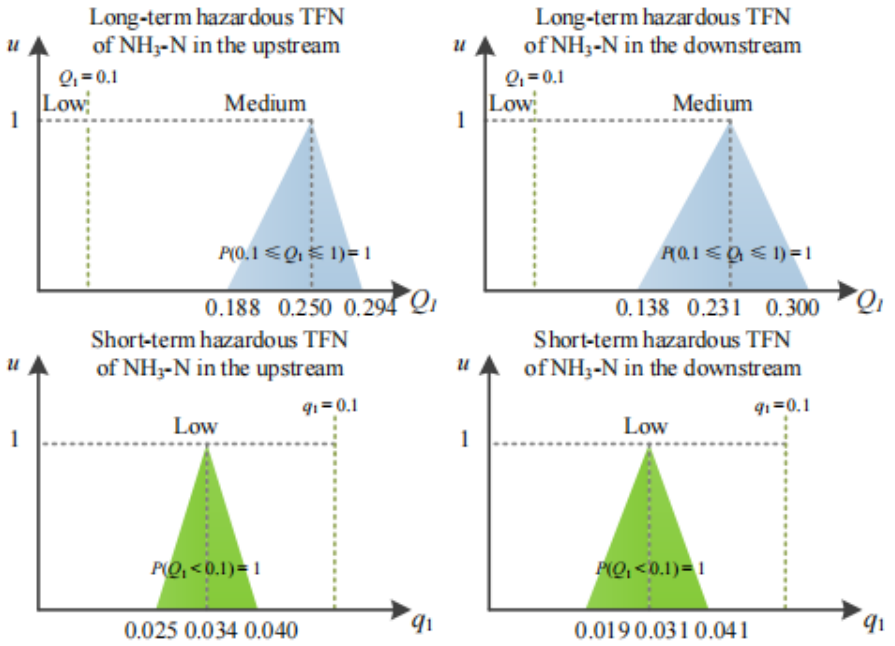
Figure 7. Hazardous TFNs of NH 3 -N after dam construction.